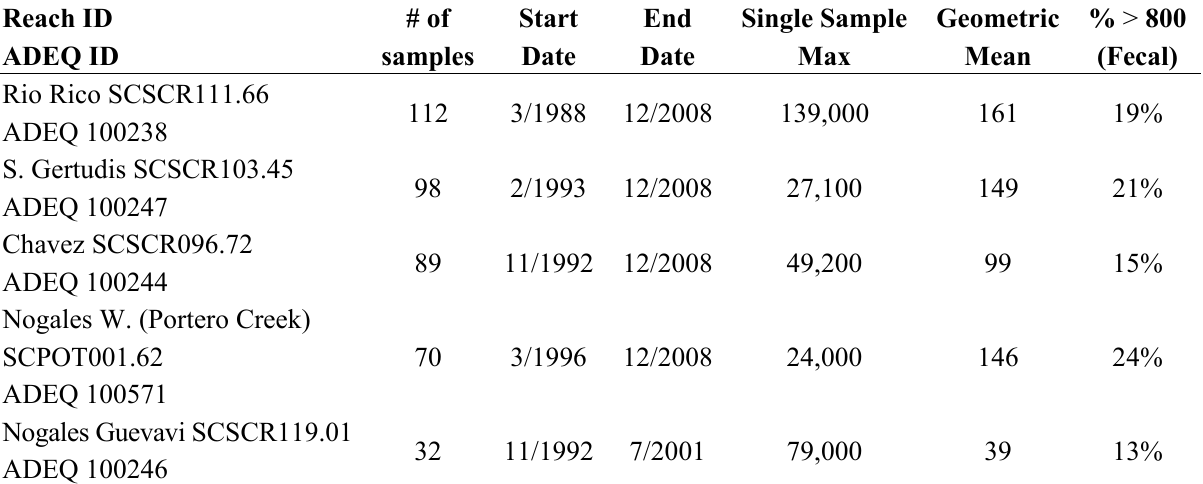
Table 4. Fecal coliform concentration (cfu/100 mL) summary from in-stream sampling locations in the Upper Santa Cruz